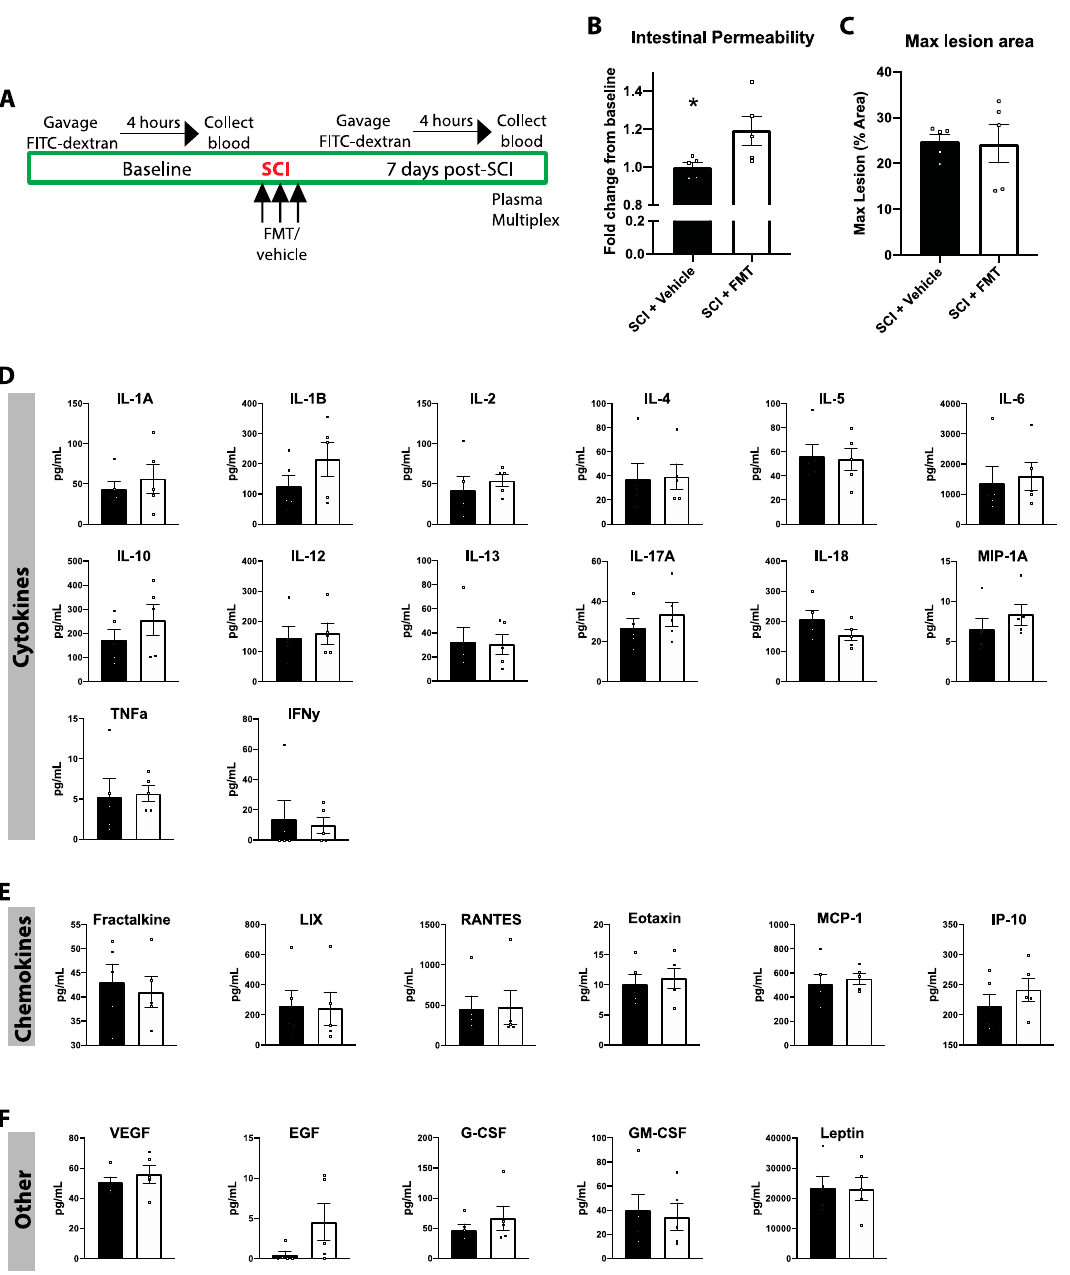
Figure 9. FMT from anxious donors increased intestinal permeability. ( A ) The FITC-dextran test for intestinal permeability was performed at baseline prior to spinal cord injury and again 7 days after injury. ( B ) SCI + FMT rats displayed significantly increased intestinal permeability relative to vehicle controls. ( C ) There were no differences between groups in the maximum lesion size. 7 days following injury, plasma was extracted and analyzed for levels of various cytokines ( D ), chemokines ( E ) and other growth factors, glycoproteins and hormones ( F ). * p < 0.05. Error bars represent standard error mean.